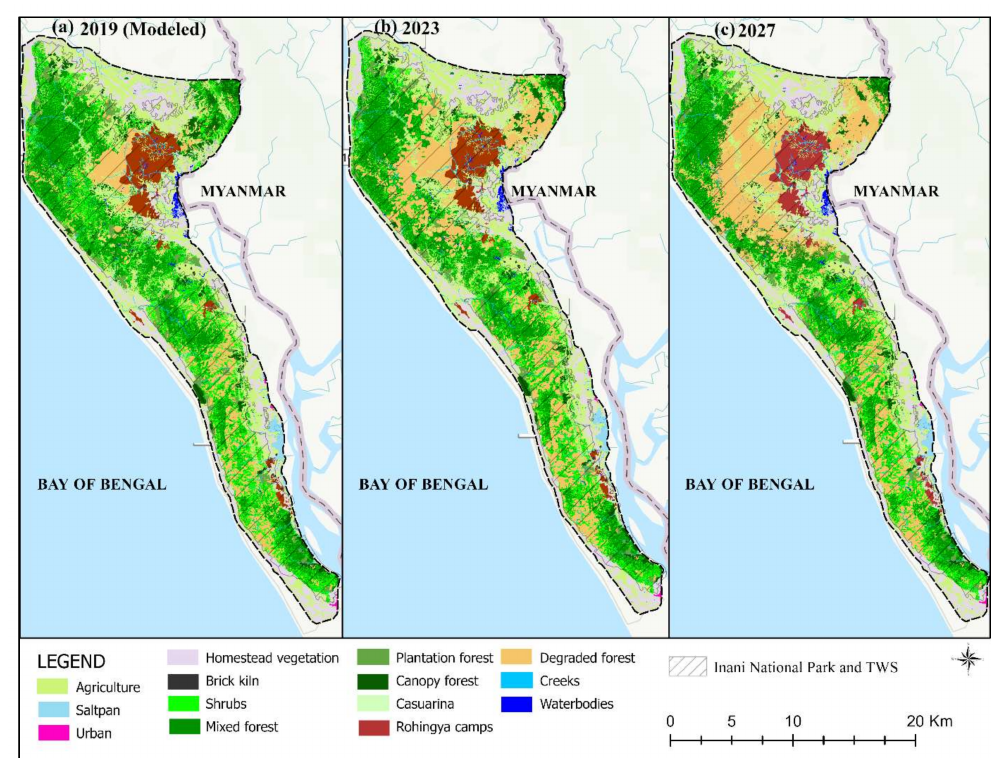
Figure 3. Predicted land use and forest cover of the study area. ( a ) is the experimentally modeled map derived from the land use and forest cover data of 2017 and 2018. ( b ) and ( c ) are the predicted land use and forest cover maps for 2023 and 2027, respectively, derived from land use and forest cover maps of 2017 and 2019.